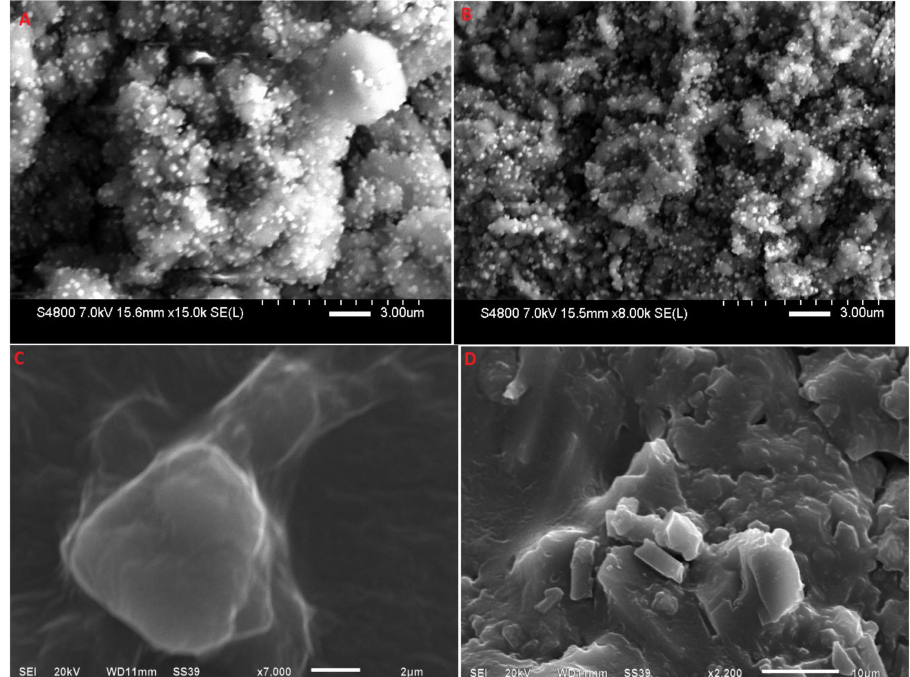
Figure 5. SEM images of ( A ) lyophilized RP-SLN formulation, ( B ) lyophilized RP-NLC formulation, ( C ) RP-SLN-C formulation, and ( D ) RP-NLC-C formulation.